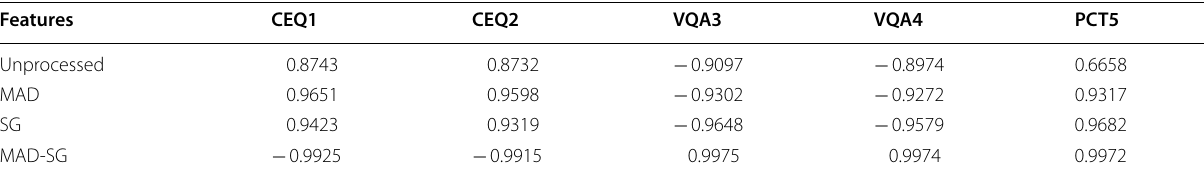
Table 4 Pearson correlation rates between the five features and capacity of B0005 battery Features